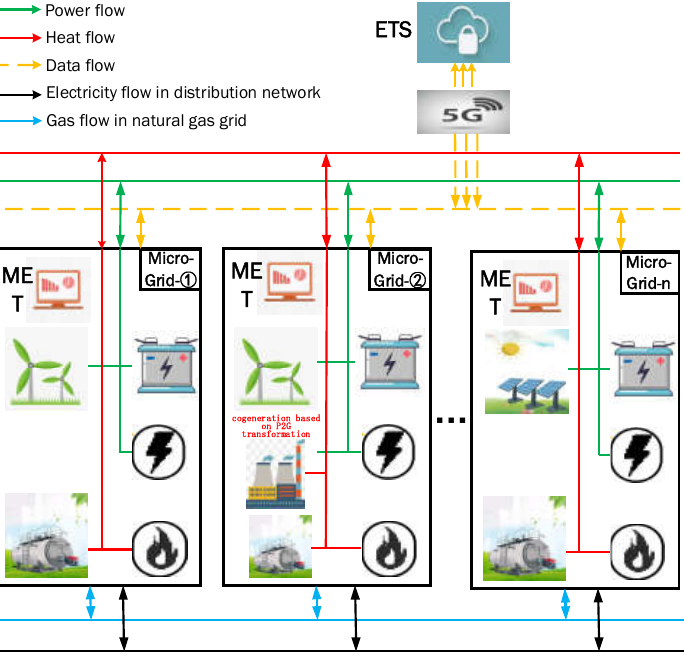
Figure 1. Multi-microgrid main P2P electric heating energy sharing architecture diagram.